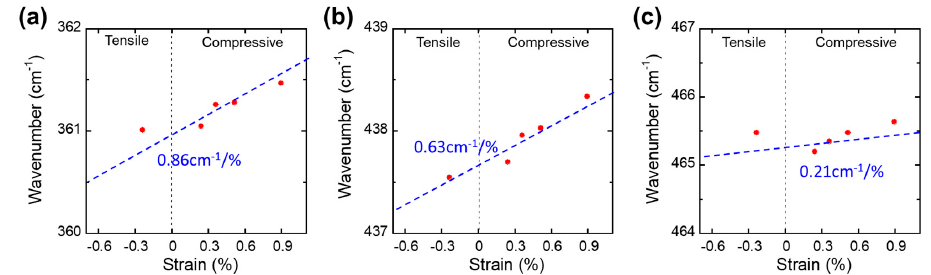
Figure 6. P peaks of ( a ) A g1 , ( b ) B 2g , and ( c ) A g2 Raman modes as a function of the applied strain.